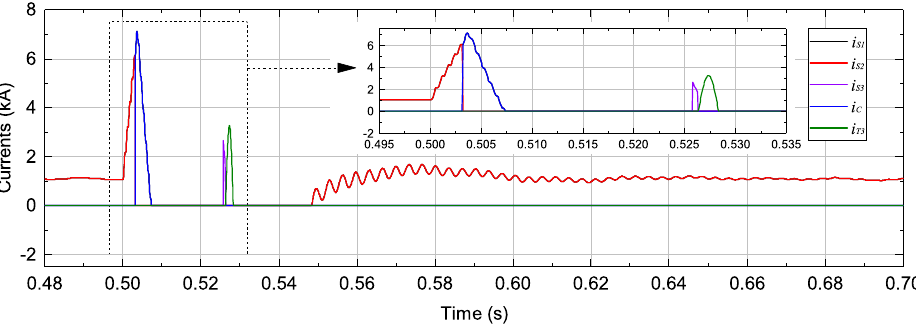
Figure 8. Overall currents on the switches of HCB 1.